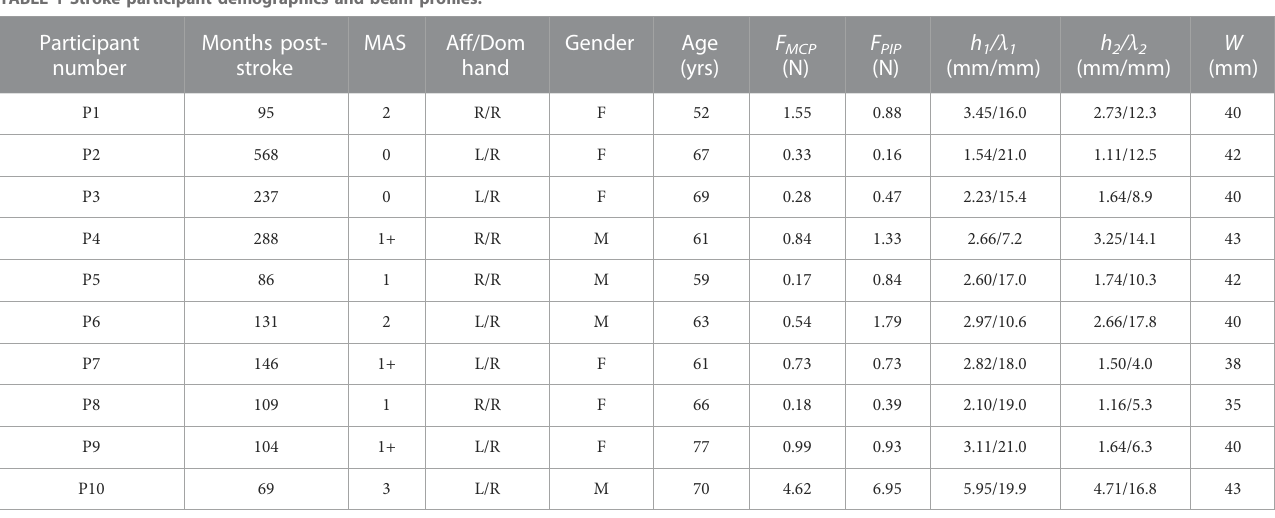
Ten chronic stroke participants with different hand anthropometric dimensions and degrees of spasticity were recruited. *F MCP , F PIP , denote joint resistive forces and h 1 , h 2 , λ 1 , λ 2 , W denote dimensions of the beam (thickness, longitudinal length, and